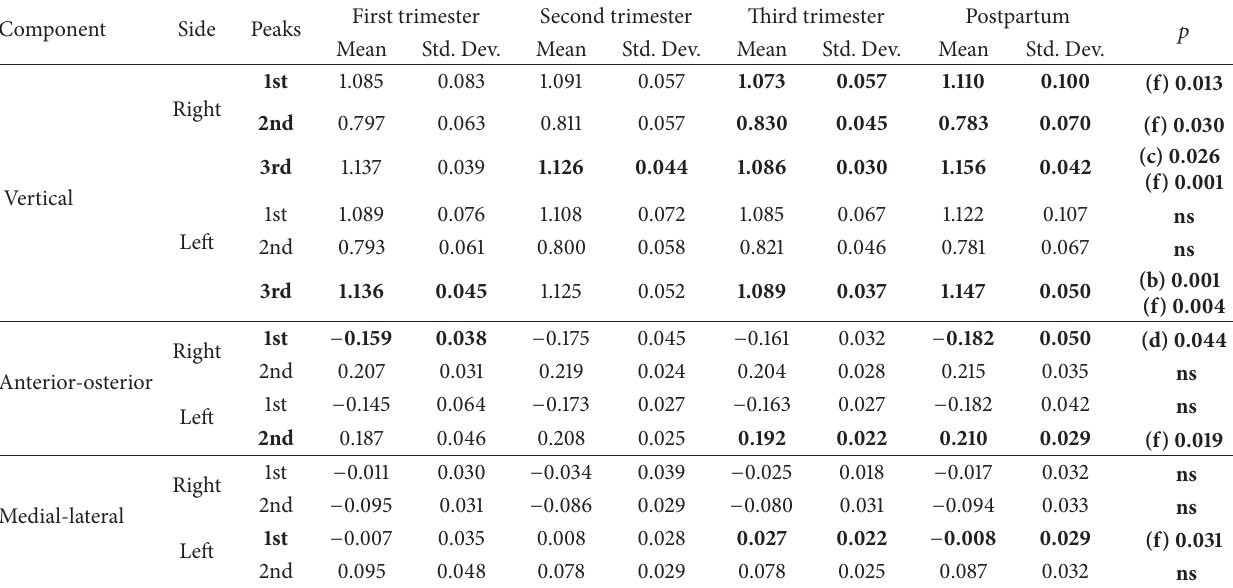
Table1:Meanandstandarddeviationofthepeakvaluesforvertical,anterior-posterior,andmedial-lateralcomponentsofthegroundreaction